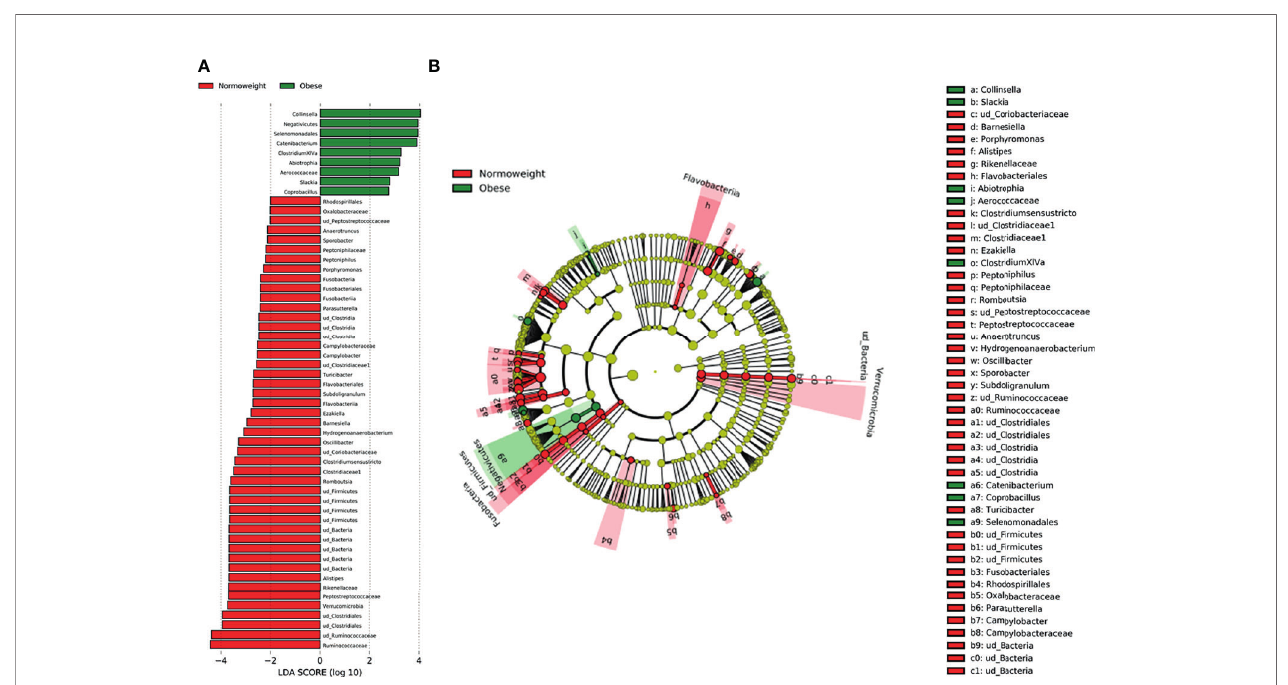
FIGURE 5 | Characterization of microbiomes by LEfSe analysis and LDA. (A) Histogram of the LDA scores (log10) computed for features with differential abundance in normal weight (N) and obese (O) subjects. (B) Cladograms showing the signi fi cant differences of gut microbiota composition in normoweight (N) and obese (O) subjects.